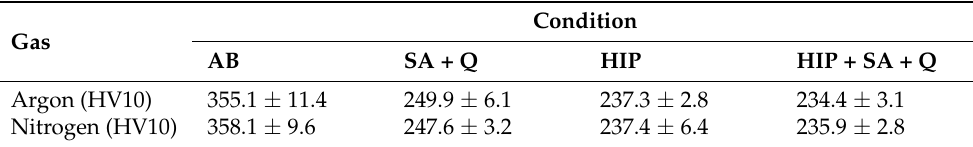
Table 2. Vickers hardness values (HV10) of L-PBF-processed AISI 318LN in the conditions AB, SA + Q, HIP, and HIP + SA +